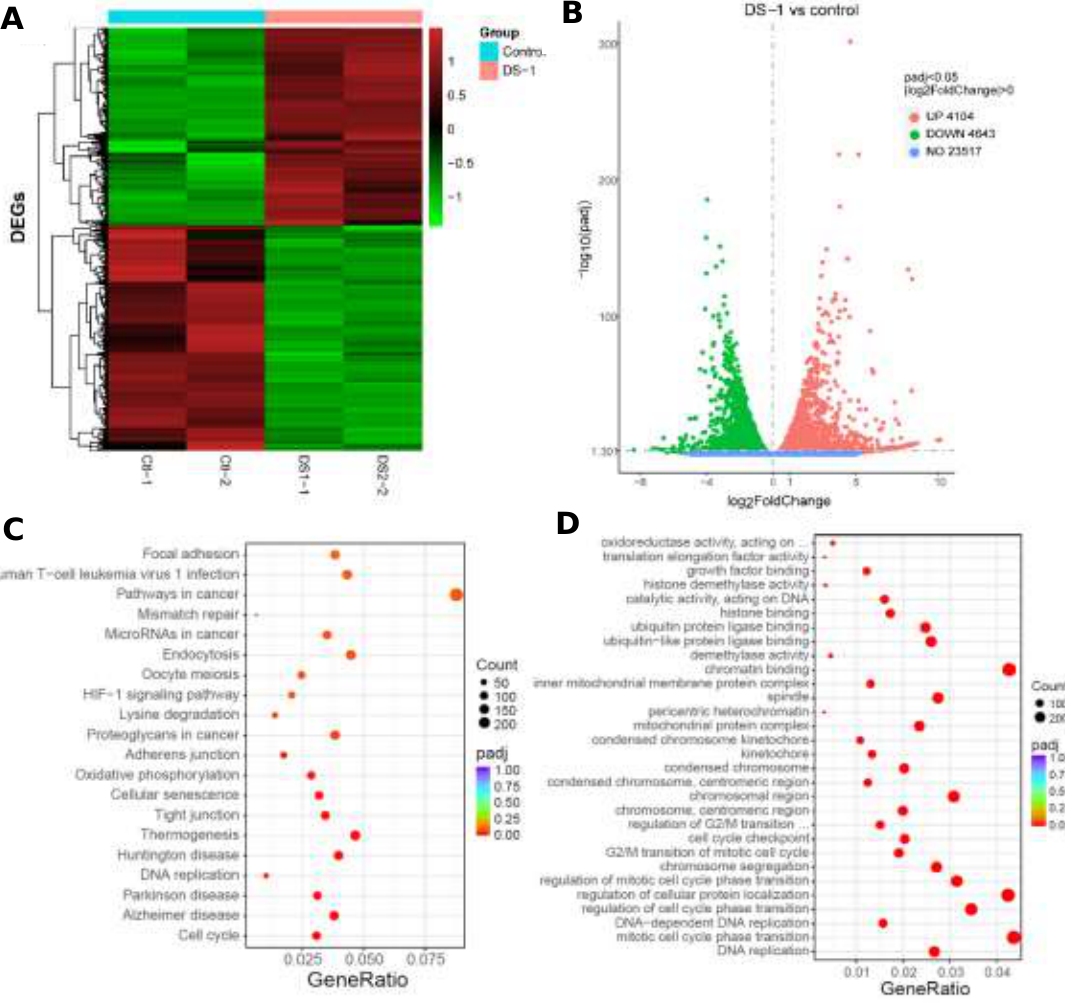
Figure 4. RNA-seq gene expression analyses of U − 2 OS cells with/without DS − 1 (6.25 µ M). ( A ) Heatmap of detected genes differentially expressed in the control group and DS − 1 group. ( B ) Volcano map of detected genes differentially expressed in the control group and DS − 1 group. ( C ) Kyoto Encyclopedia of Genes and Genomes (KEGG) analysis of differentially expressed genes. ( D ) Gene Ontology (GO) term analysis of differentially expressed genes is shown in the scatter plots.